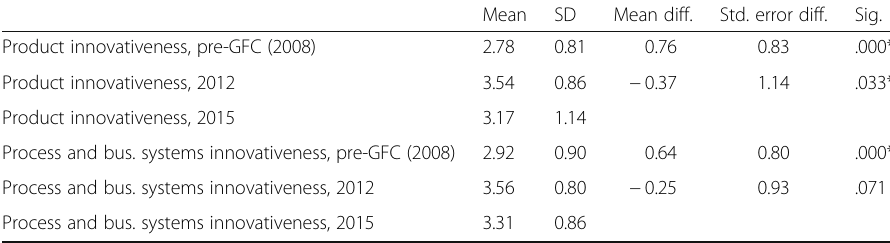
Table 2 Change in innovativeness pre-GFC to 2012 to 2015 ( n = 46) Mean SD Mean diff. Std. error diff. Sig.